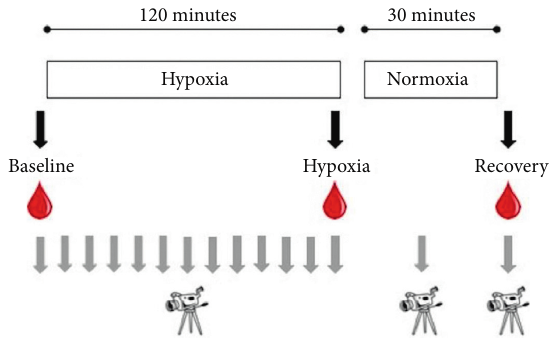
Figure 2: Blood samples were collected before, during, and after hypoxia. Thermographic images were obtained every tenth minute during hypoxia as well as 15 and 30 minutes after